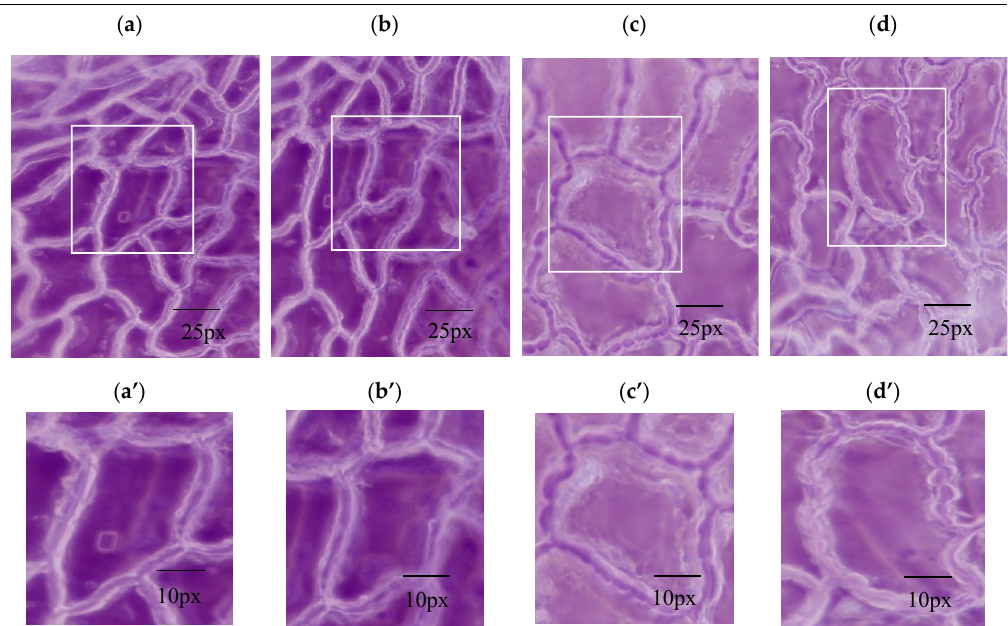
Figure 4. The photomicrograph ( a – d ) and magnified montages of boxed regions in images above ( a’ – d’ ) of Folium nelumbinis by different extracting methods. Scope Image 9.0, magnification times: 400 × . ( a , a’ )—Single-phase extraction; ( b , b’ )—Ultrasound-assisted single-phase extraction; ( c , c’ )—Osmosis extraction; ( d , d’ )—Ultrasound-assisted osmosis extraction.